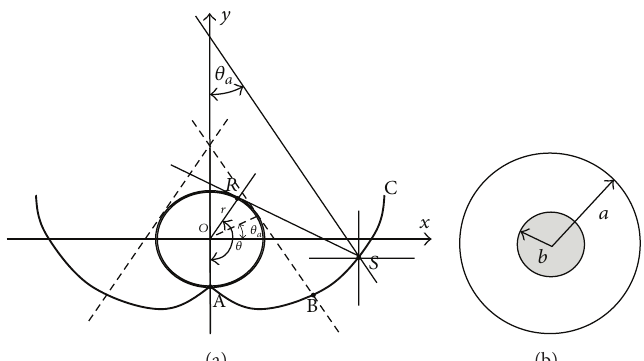
Figure 1: (a) CPC acceptance angles, (b) Schematic cross section representation of used annulus to flow the wastewater